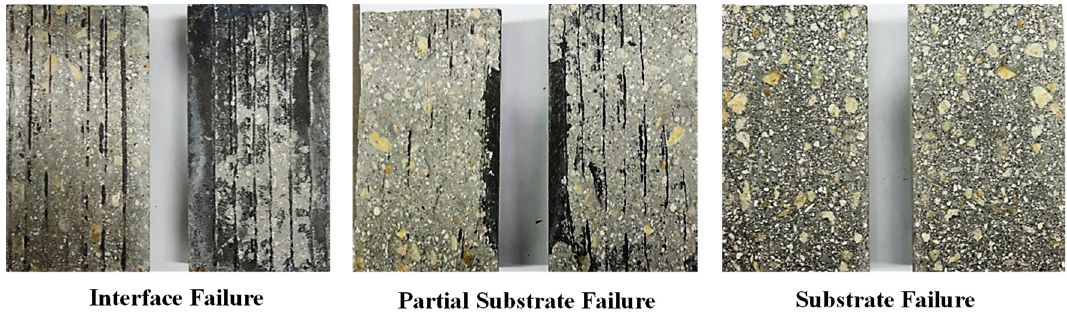
Figure 3. Representative picture of different failure modes after exposure.